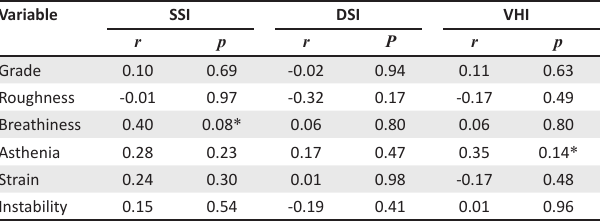
TABLE 7: Correlations between the stuttering severity instrument, Dysphonia Severity Index and Voice Handicap Index and grade of hoarseness, roughness, breathiness, asthenia, strain and instability